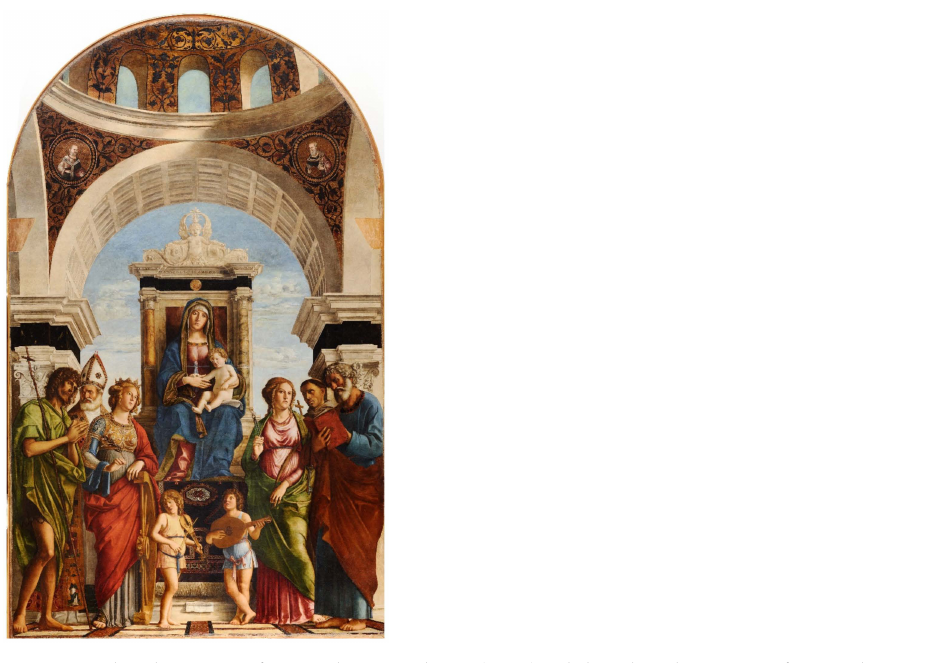
Figure 1. The altarpiece of Cima da Conegliano (1493) exhibited in the Dome of